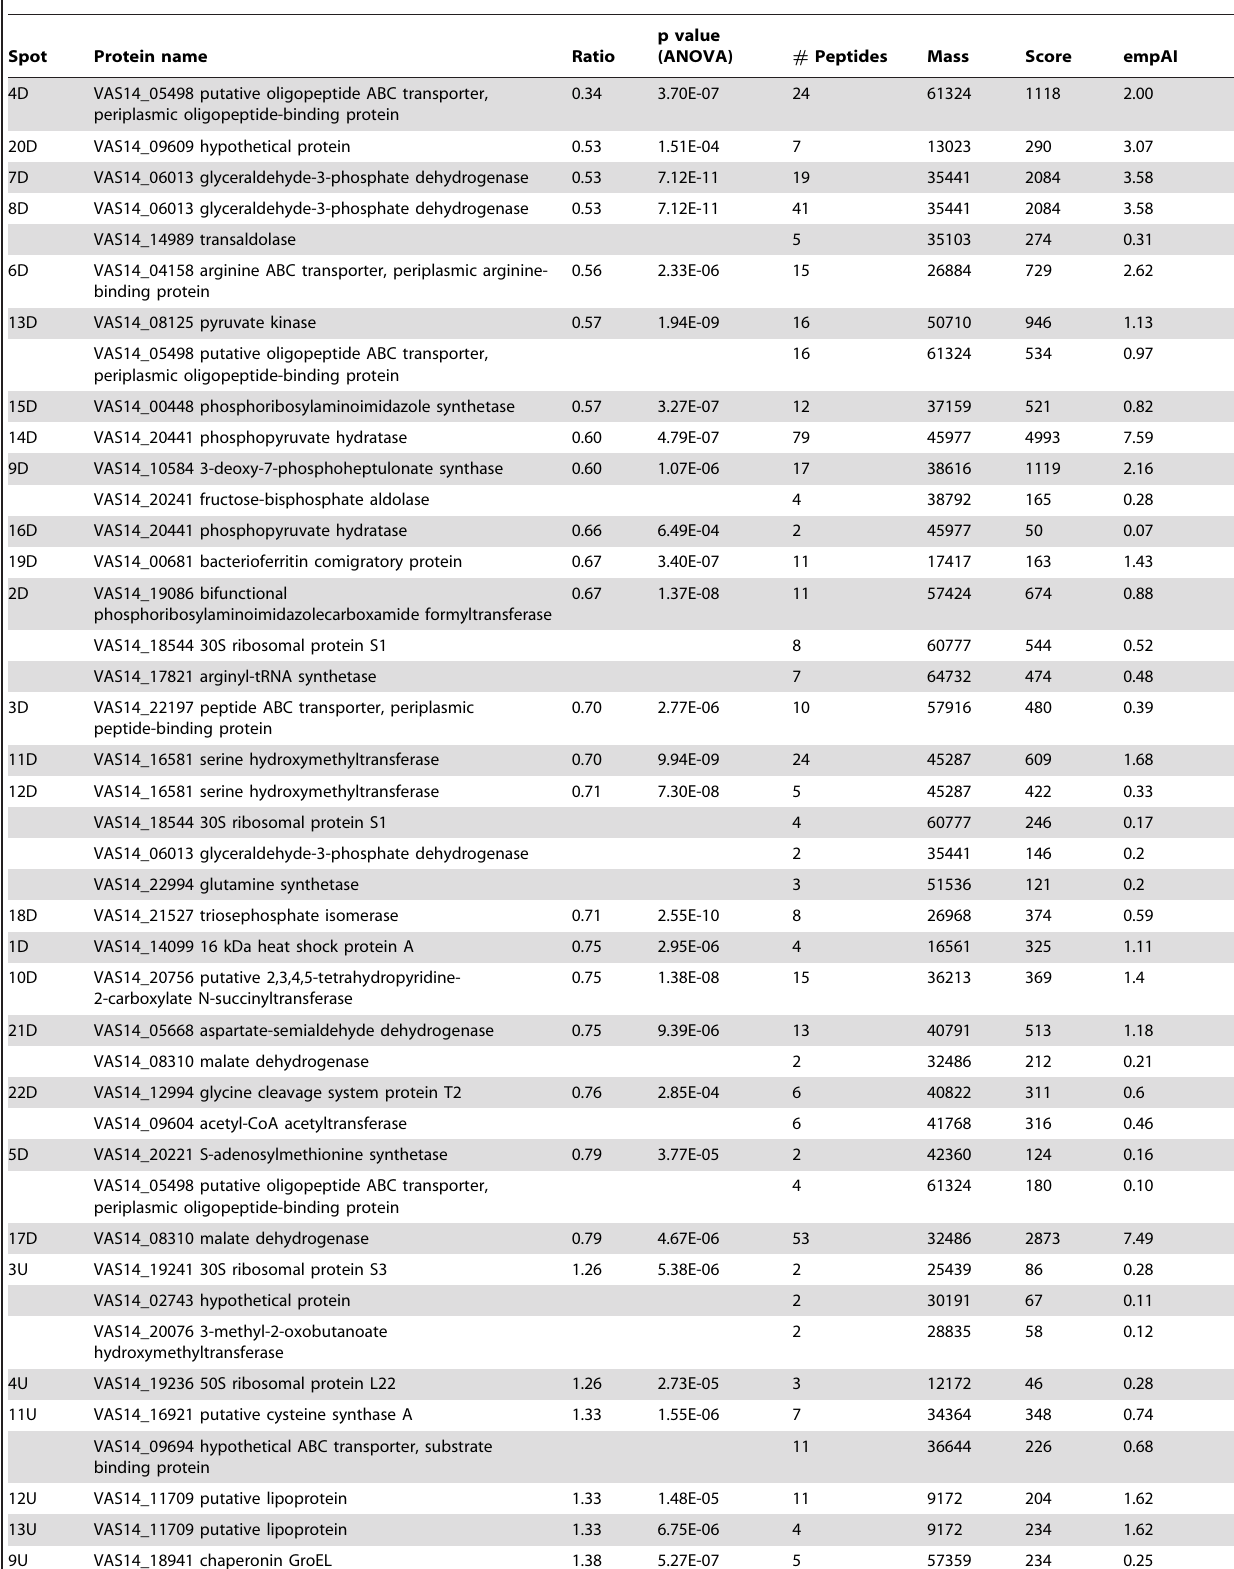
Table 2. Identification of the two-dimensionally separated protein spots of interest with the average fold change and associated p-values obtained from seven